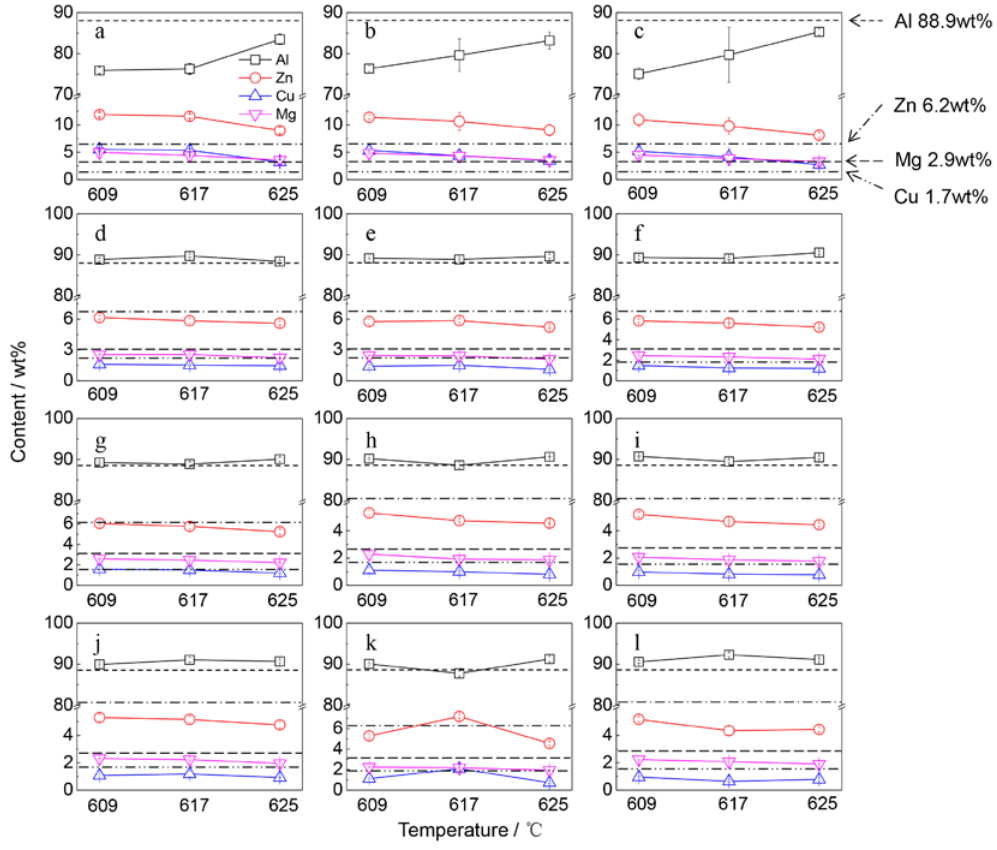
Figure 5. The compositions of different layers in trials 1–9: ( a – c ) layer 1, ( d – f ) layer 2, ( g – i ) layer 3, ( j – l ) layer 4, ( a , d , g , j ) 400 G , ( b , e , h , k ) 700 G , ( c , f , i , l ) 1000 G .